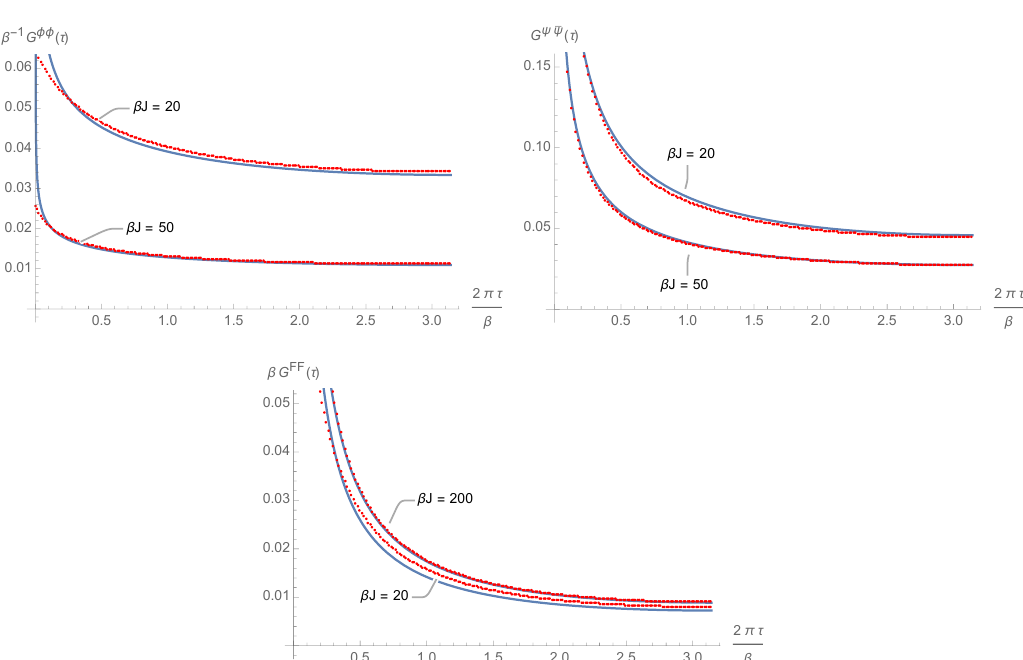
Figure 4. Comparison of numerical (red) and analytic (blue) solutions of the supersymmetric Schwinger-Dyson equations for q = 6 and b (cid:30) J 2(cid:1) (cid:30) +1 = 1 (for di(cid:11)erent choices of the dimensionless coupling (cid:12)J as indicated). The numerical calculation is still with a discretized temporal grid with 200 points (see footnote 9 for comments on increasing the resolution). For G FF we have speci(cid:12)cally chosen a larger value of (cid:12)J to separate out the curves for ease of